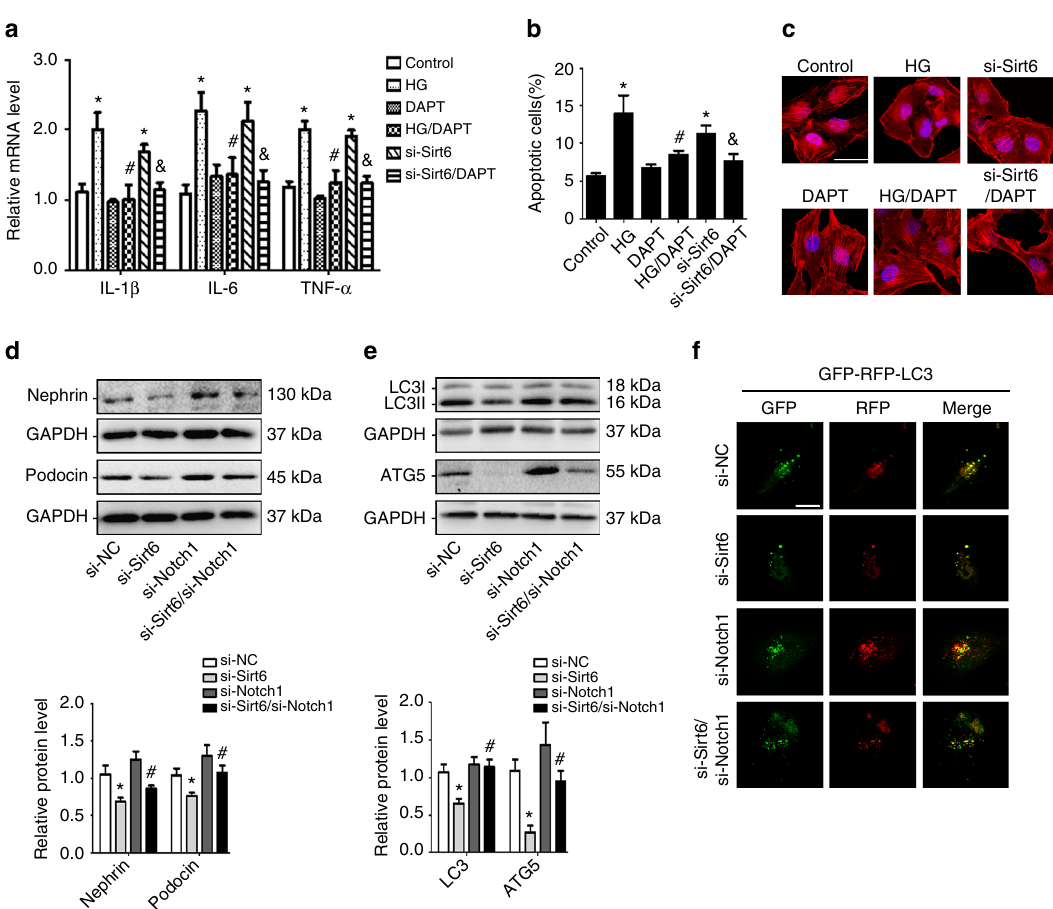
Fig. 7 Inhibition of the Notch pathway rescues the functional defect in Sirt6 -de fi cient podocytes. a The relative levels of pro-in fl ammatory mediators in podocytes with different treatments. b Summarized data showing the level of podocyte apoptosis determined by fl ow cytometric analysis in podocytes with different treatments. Podocytes were stained with fl uorescein isothiocyanate (FITC)-conjugated Annexin V and propidium iodide (PI), and analyzed by fl ow cytometry. * P < 0.05 vs. control, # P < 0.05 vs. scramble of HG treatment, & P < 0.05 vs. siRNA-transfected podocytes. ( n = 6.) c Representative confocal microscopic images showing that actin cytoskeleton derangement as evidenced by the loss of actin fi laments and a granular cytoplasmic pattern of actin was ameliorated by DAPT with different treatments. Scale bar , 40 μ m. d Representative western blot gel documents and summarized data showing that gene silencing of Notch1 restored the expressions of nephrin and podocin in Sirt6 -de fi cient podocytes ( n = 6). e Representative western blot gel documents and summarized data showing that gene silencing of Notch1 rescued the autophagy defect in Sirt6 -de fi cient podocytes ( n = 6). f Representative images of LC3 staining by measurement of fl uorescent intensity in podocytes showing LC3 staining in different groups of podocytes infected with RFP-GFP-LC3 adenovirus for 24 h. Scale bar , 20 μ m. * P < 0.05 vs. si-negative control, # P < 0.05 vs. si-Sirt6 transfected podocytes. ( n = 6.) Data are expressed as means ± SE. One-way ANOVA followed by Tukey ’ s post-test for multiple comparisons was used for groups of three or